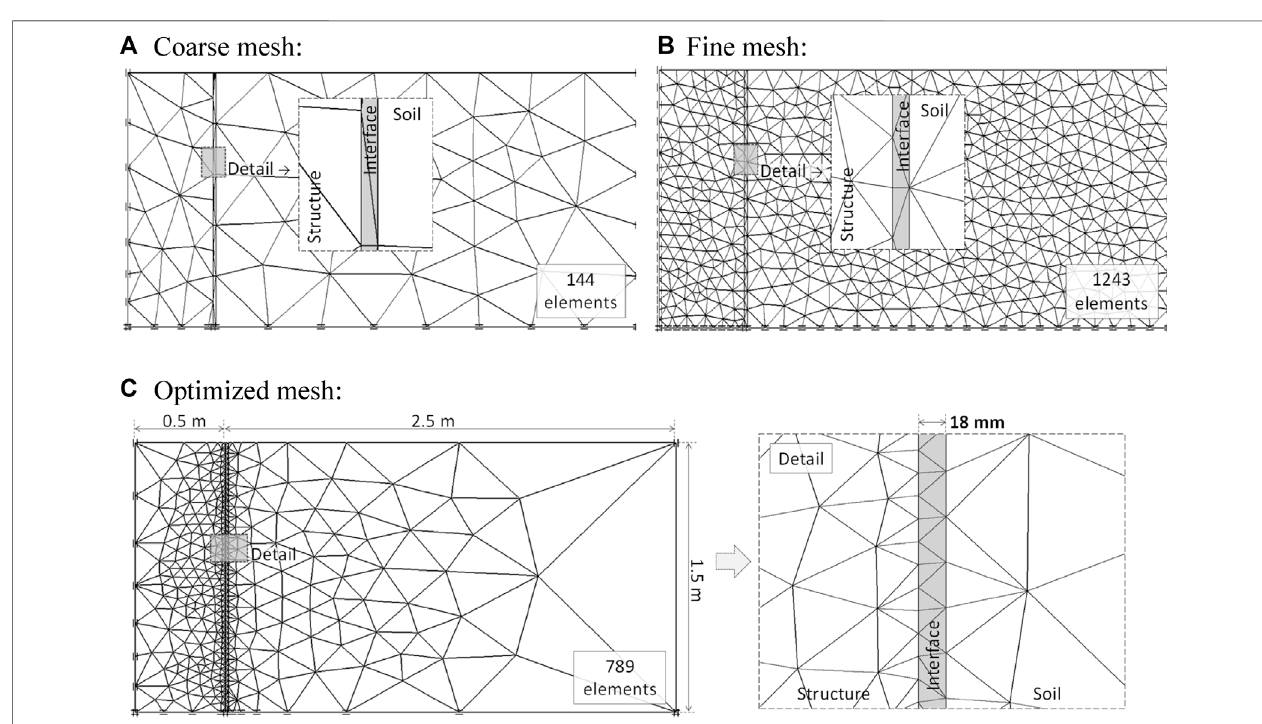
FIGURE 2 | Three different fi nite element meshes (15 node triangular elements) for the same soil – structure interaction example using program PLAXIS: (A) coarse mesh, (B) fi ne mesh, and (C) optimized mesh with the same interface thickness of ti = 0.018 m (Damians et al. 2015b).